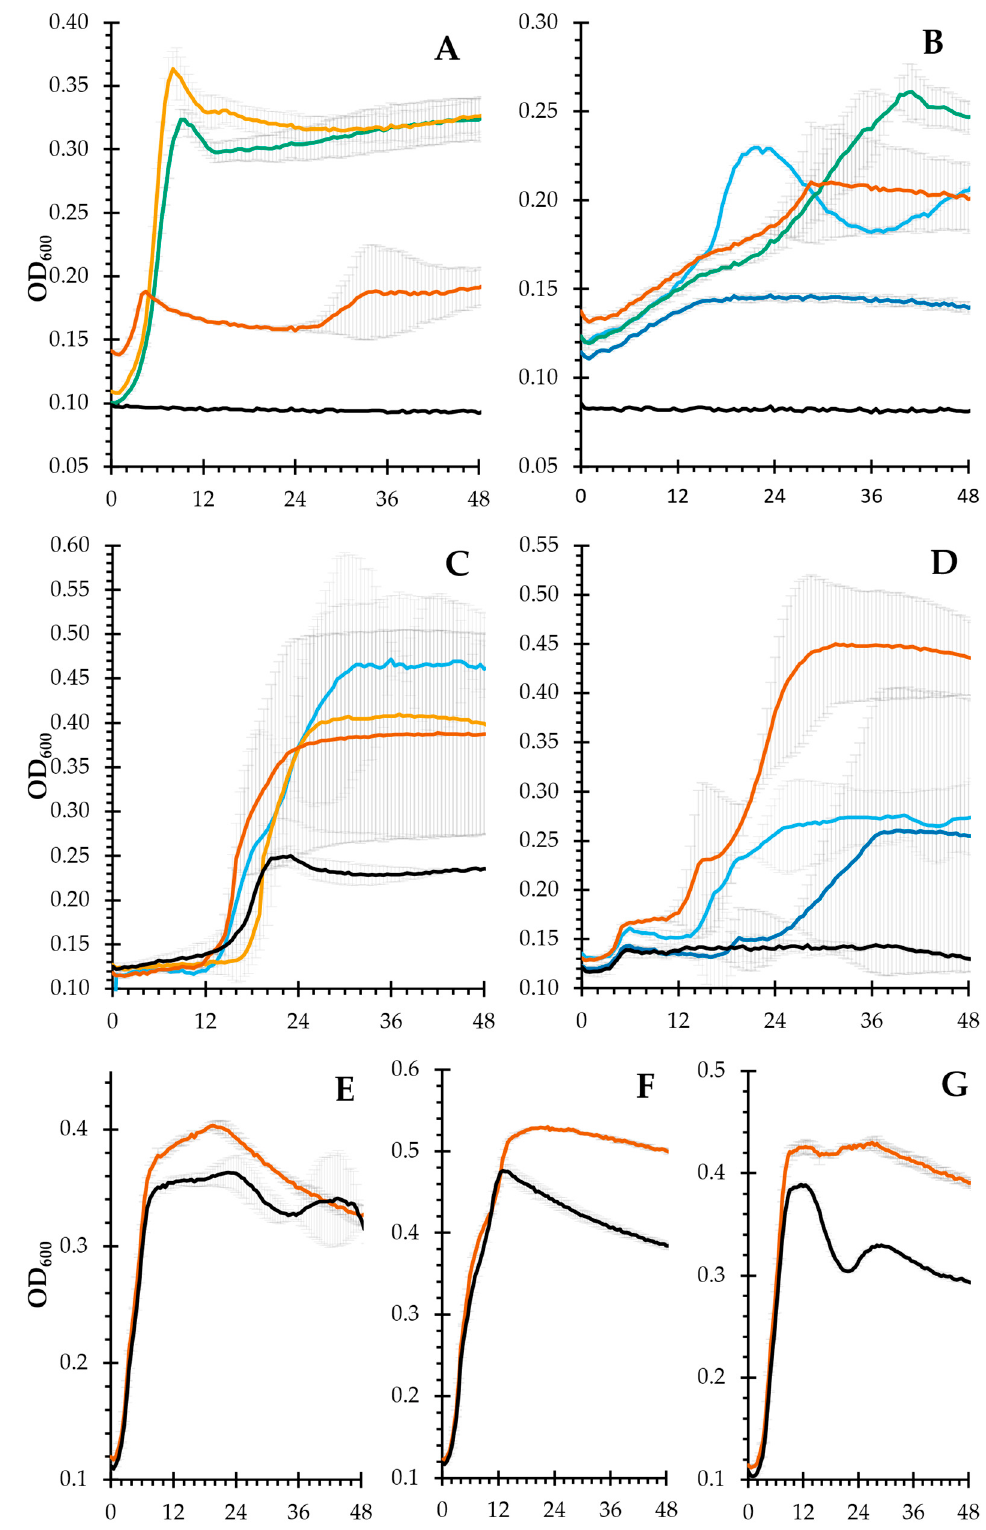
Figure 4. Atomic force microscopy representative images (5 × 5 μ m) of the mucilage extracted from O. joconostle cladodes and its composing polysaccharides. The color scale on the right indicates the height in nm.